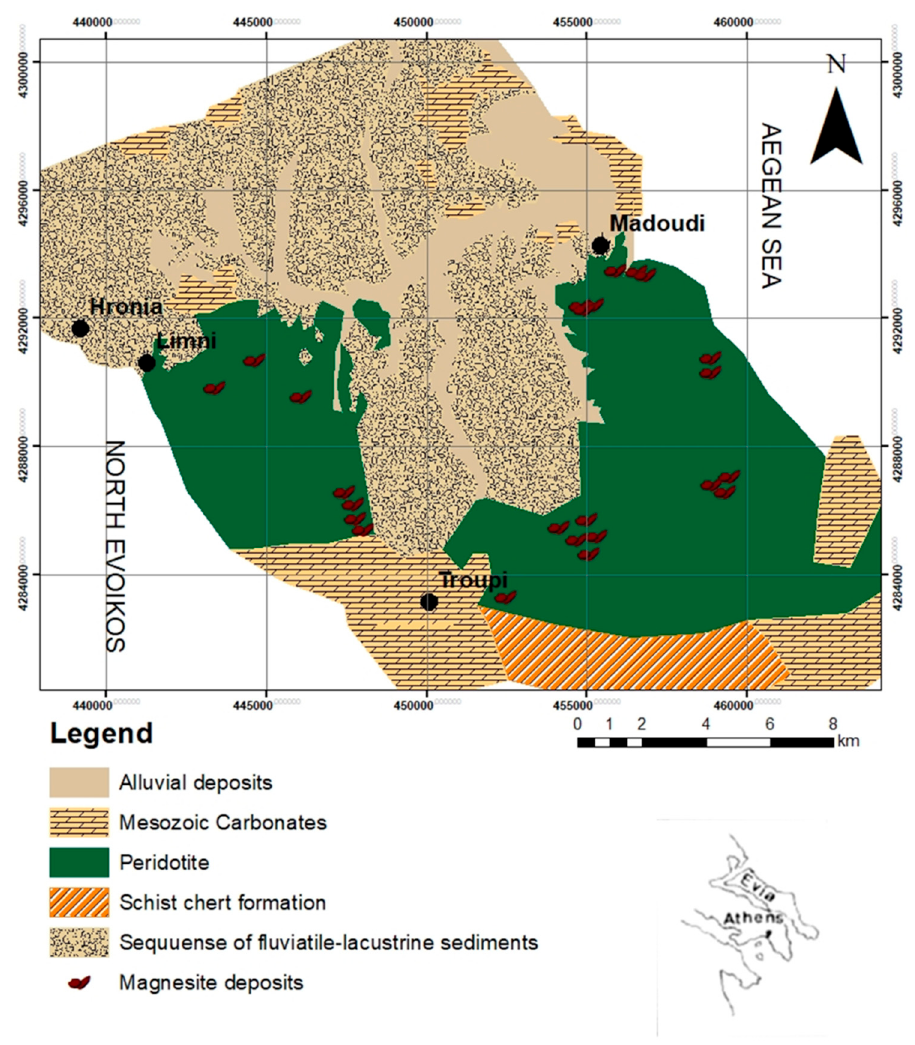
Figure 1. Modified geological map of central and northern Evoia [24] using ArcMap GIS mapping.